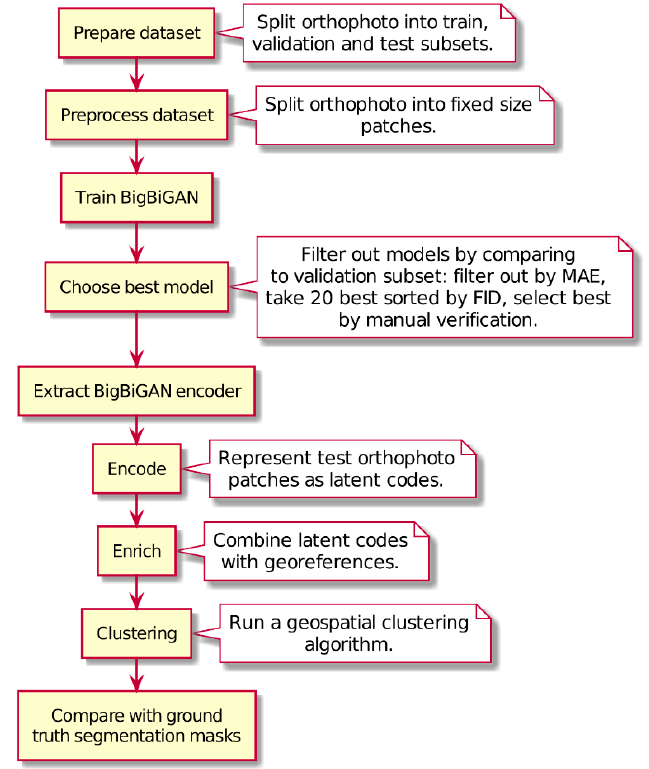
Figure 1. Investigation overview.